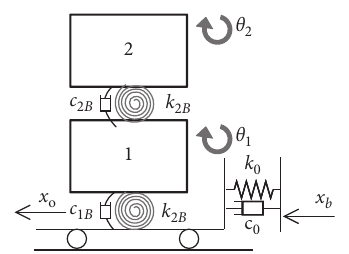
Figure 1: The experimental setup.